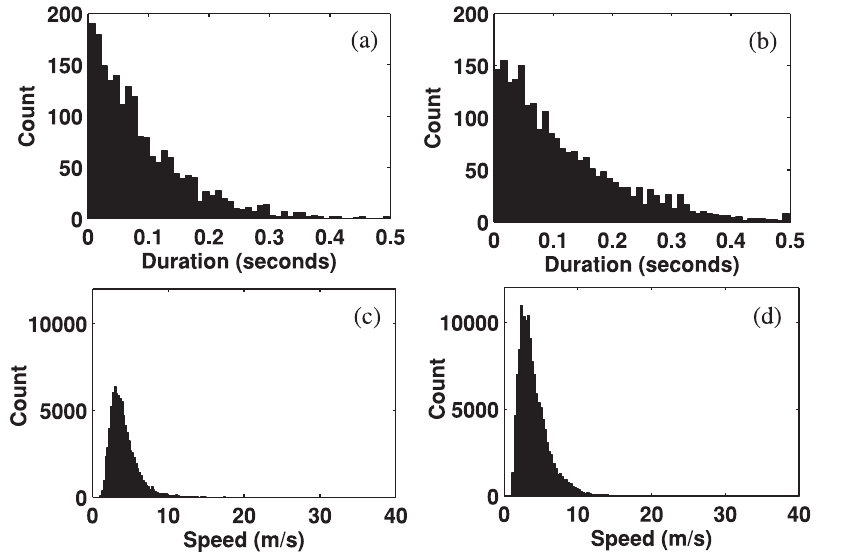
Figure 8. Histograms of the durations and speeds of prestimulus and poststimulus theta waves measured for all subjects. (a) Durations of prestimulus waves. (b) Durations of poststimulus waves. (c) Speeds of prestimulus waves. (d) Speeds of poststimulus waves.